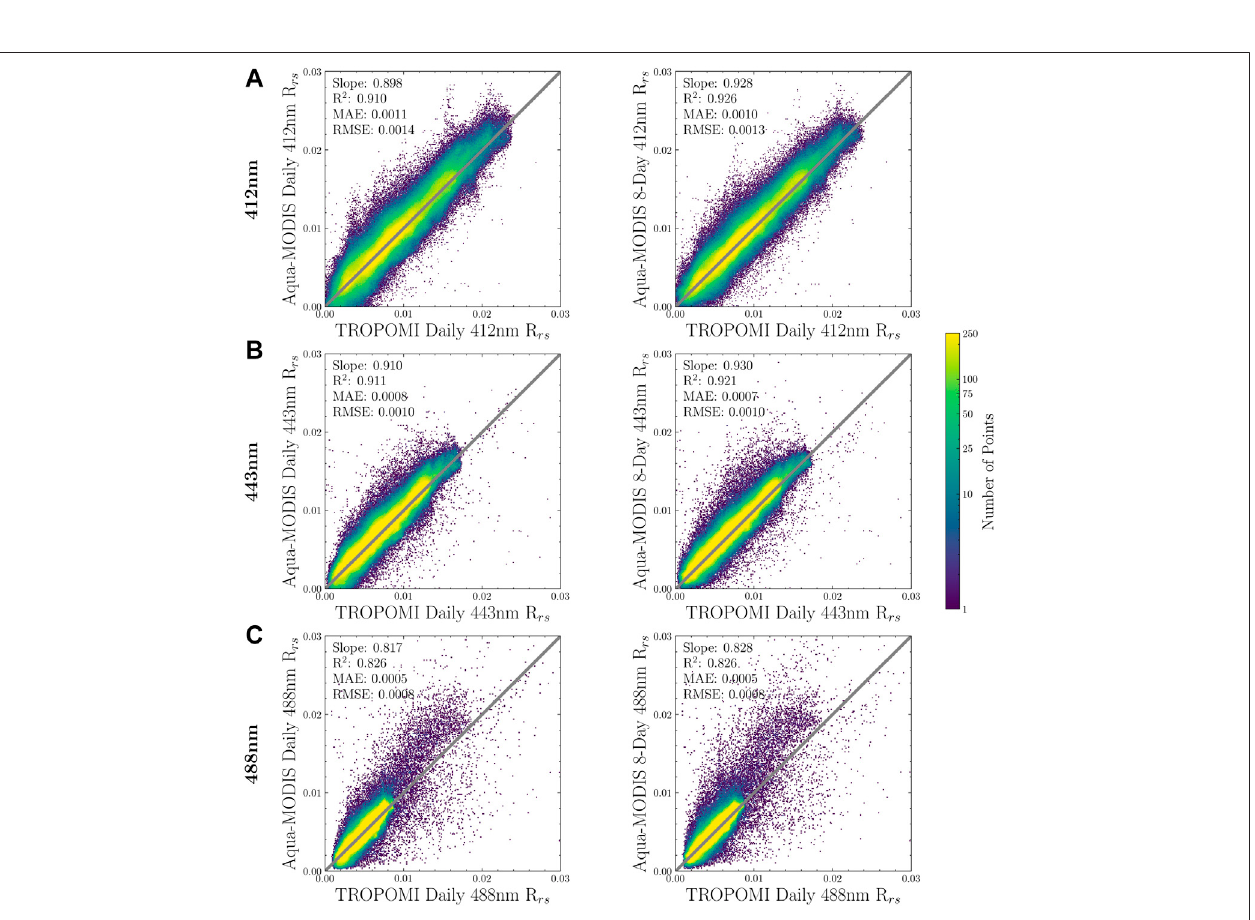
Frontiers in Remote Sensing |